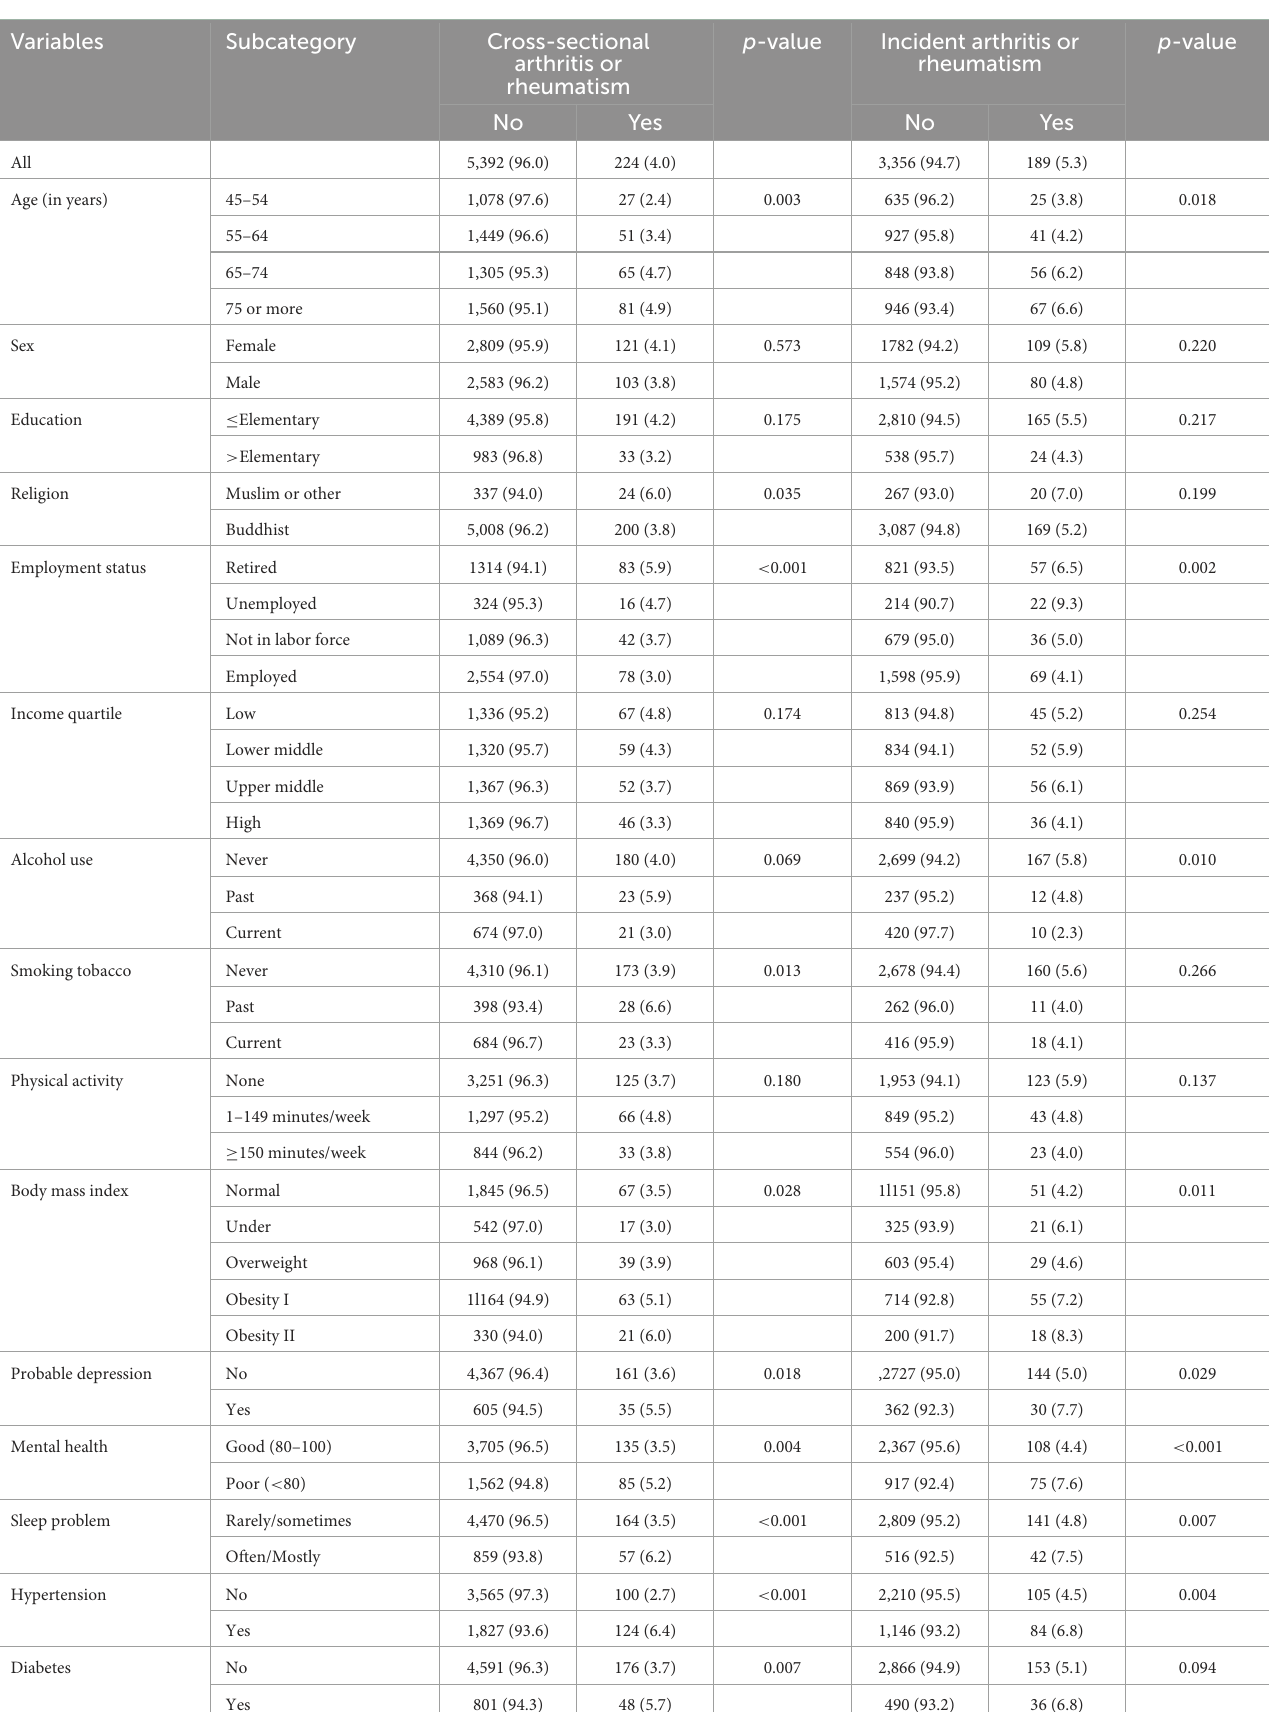
TABLE 1 Cross-sectional and incident arthritis or